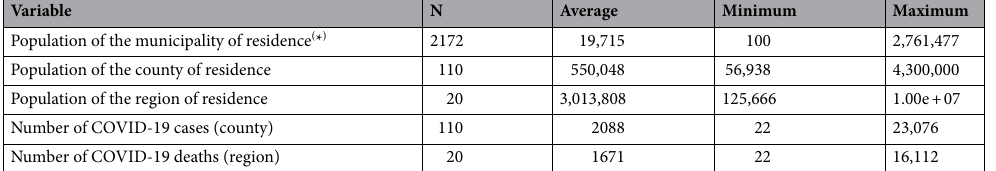
Table 4. Summary statistics of geographical variables (at the 31st of May 2020). ( * ) In Italy there are 7,982 municipalities; sample individuals live in 2,172 of them. Sources : Italian Statistical Office (ISTAT) and Italian Ministry of Health.